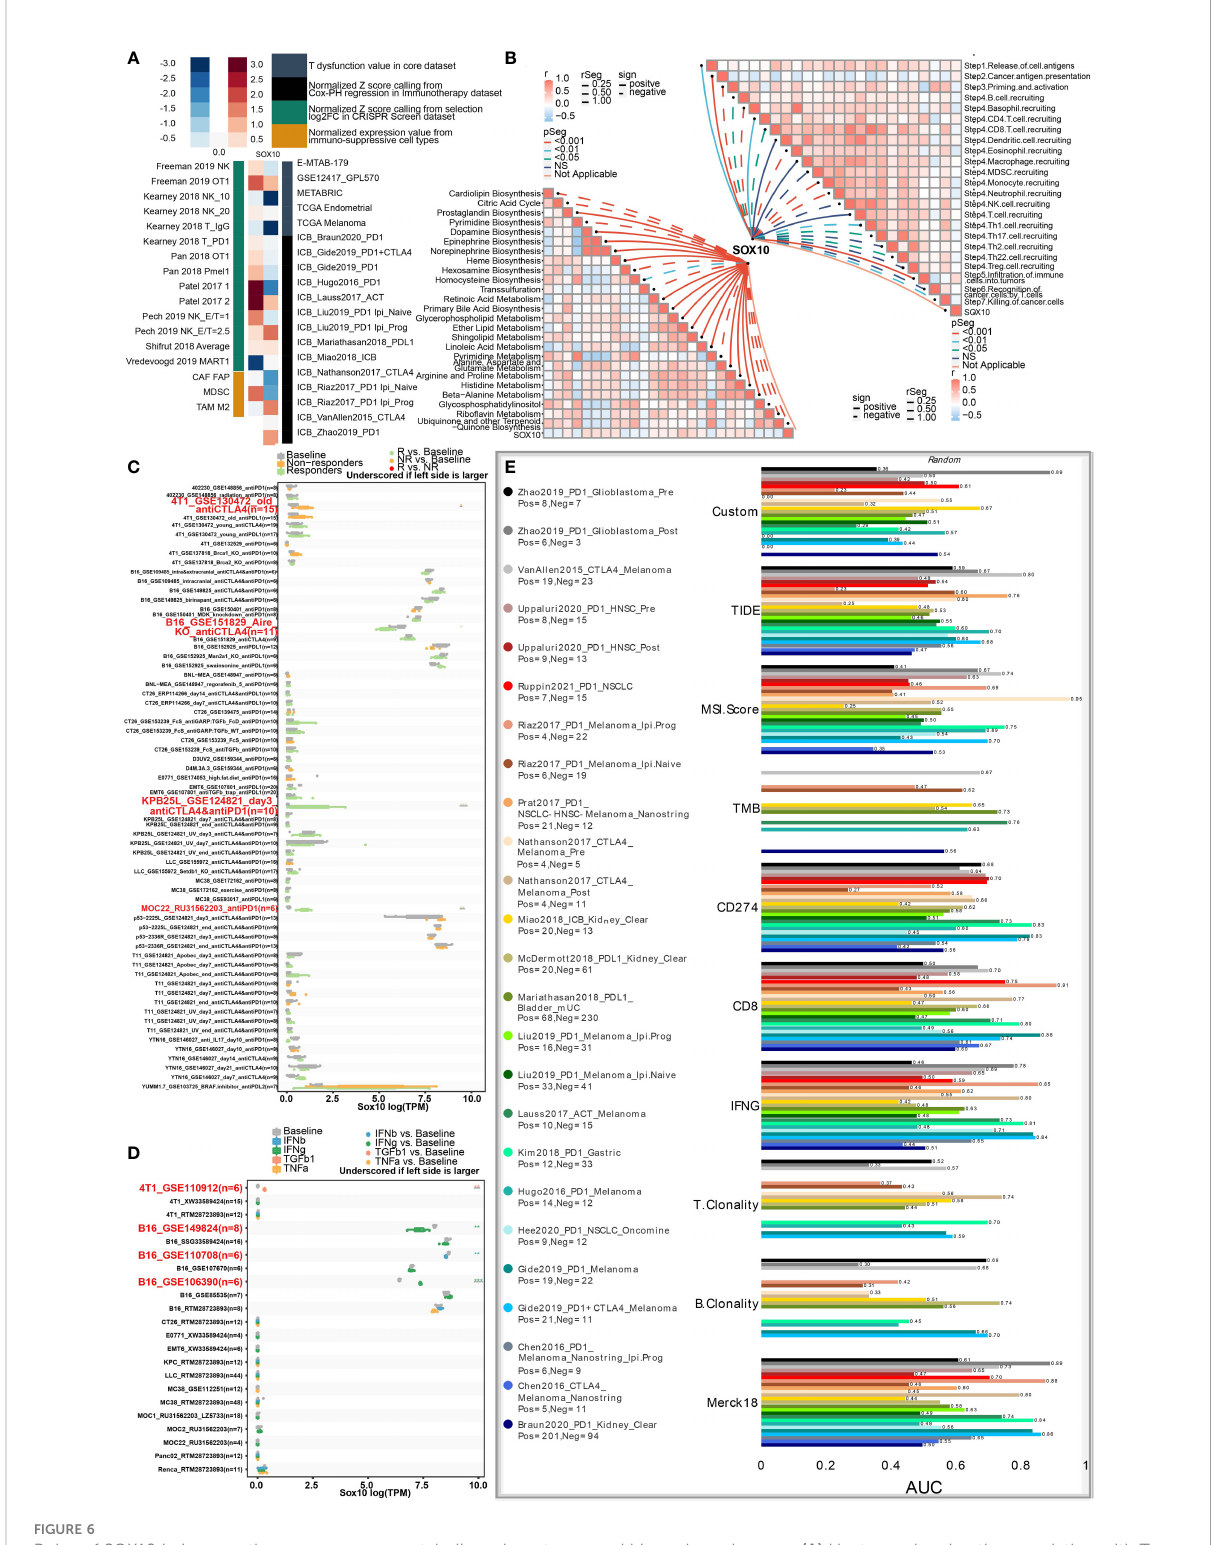
FIGURE 6 Roles of SOX10 in immunotherapy response, metabolism phenotypes, and biomarker relevance. (A) Heatmap showing the correlation with T- cell dysfunction, normalized Z score, and normalized expression. (B) Correlations between SOX10 and enrichment outcomes of metabolism- relevant pathways together with cancer-immune cascade steps. (C) Immunotherapy response of SOX10 in immunotherapy cohorts. (D) Immune effector molecule relevance of SOX10 in immunotherapy cohorts. (E) Biomarker relevance of SOX10 in immunotherapy